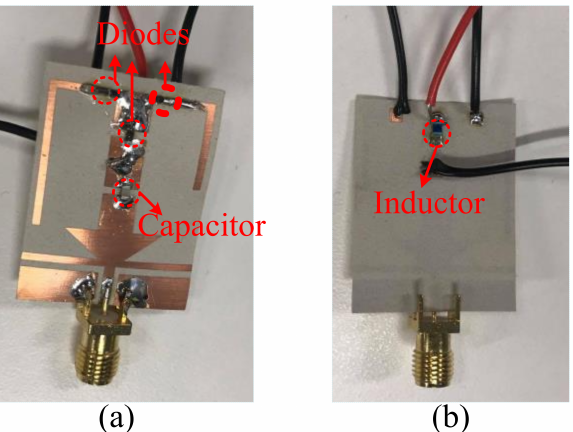
Figure 8. Fabricated prototype of the proposed flexible filtenna. ( a ) Top view. ( b ) Bottom